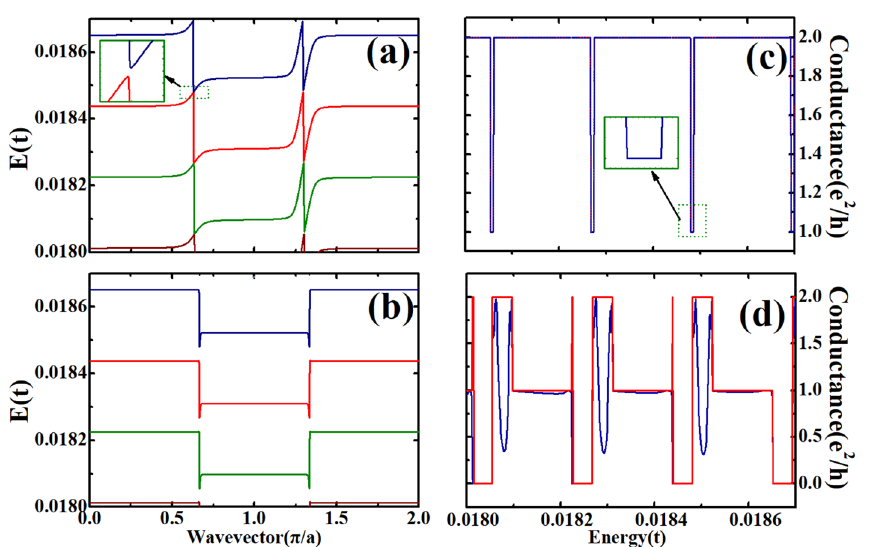
Figure 4. Band structures and conductance for the device in a small energy region. ( a ) Band structure for zigzag ribbon with both magnetic and electric fields. ( b ) Band structure for zigzag ribbon with only electric field. ( c ) Conductance for the device with and without nanoscale constrictions while both magnetic and electric fields are considered. ( d ) Conductance for the device with and without nanoscale constrictions while only electric field is